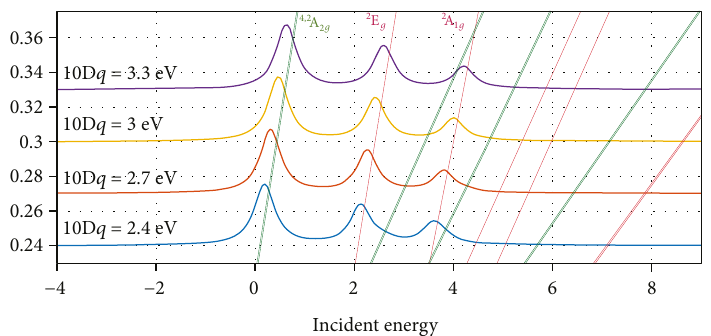
Figure 55: 1s XAS projections of the calculated 1s2p RIXS maps for a Co 2+ ion (3d 7 ) with 10D q = 2 4eV to 3 3 eV (low spin